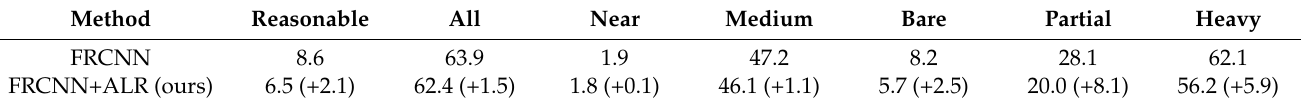
Table 4. Comparison of FRCNN+ALR with baseline across each subset of the Caltech-USA test set (MR − 2 /%). Method